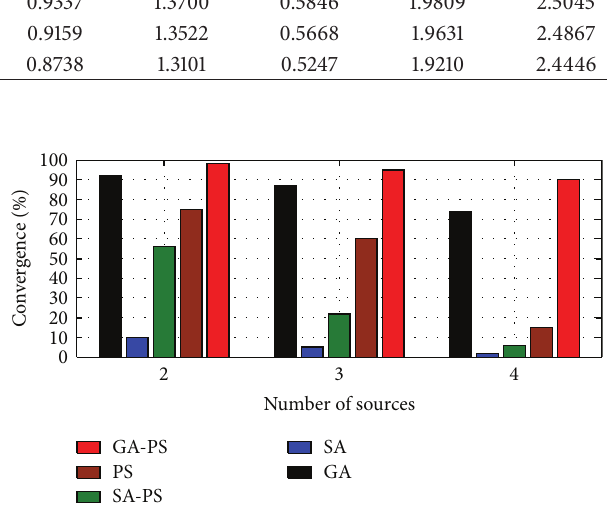
Figure 3: Convergence rate versus number of sources for 2-L-shape array at 10dB